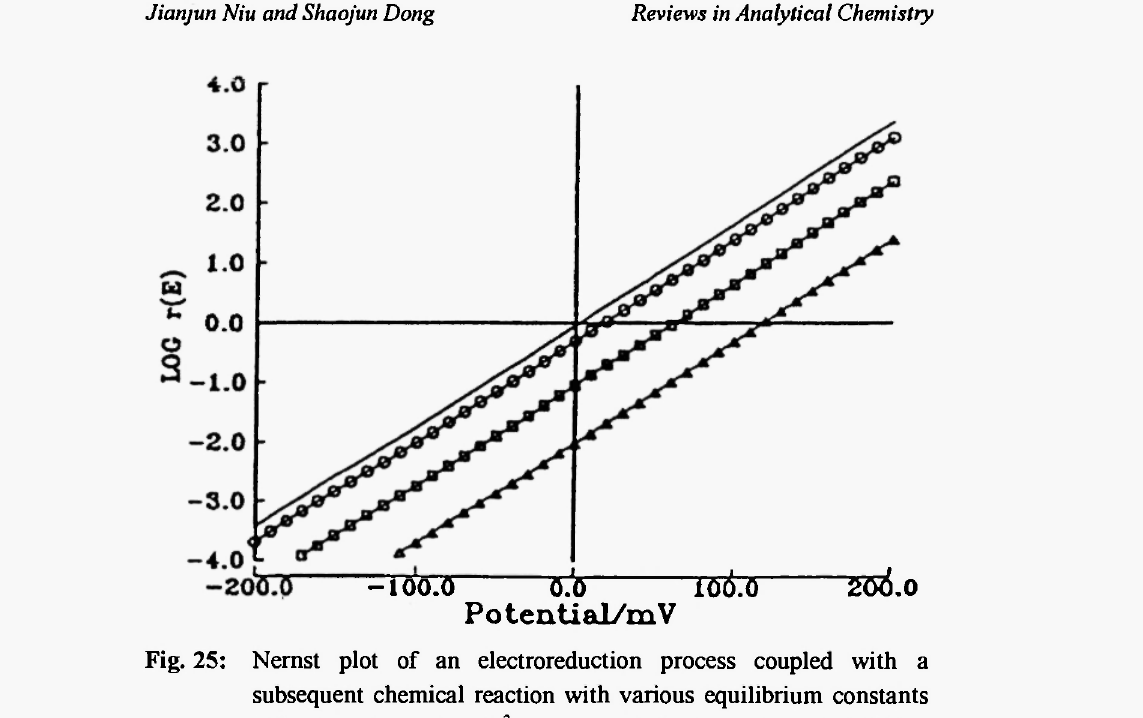
Fig. 25: Nernst plot of an electroreduction process coupled with a subsequent chemical reaction with various equilibrium constants (£° = 0 mV; ε = 1 χ ΙΟ 3 ; ε = ε · = 0; horizontal line, 1η[/·(£)] = 0 0 κ 0; vertical line Ε = 0): — K = 0.0; Ο Κ = 1.0; • Κ = 10; Δ Κ x λ λ λ = 100 (From Ref.